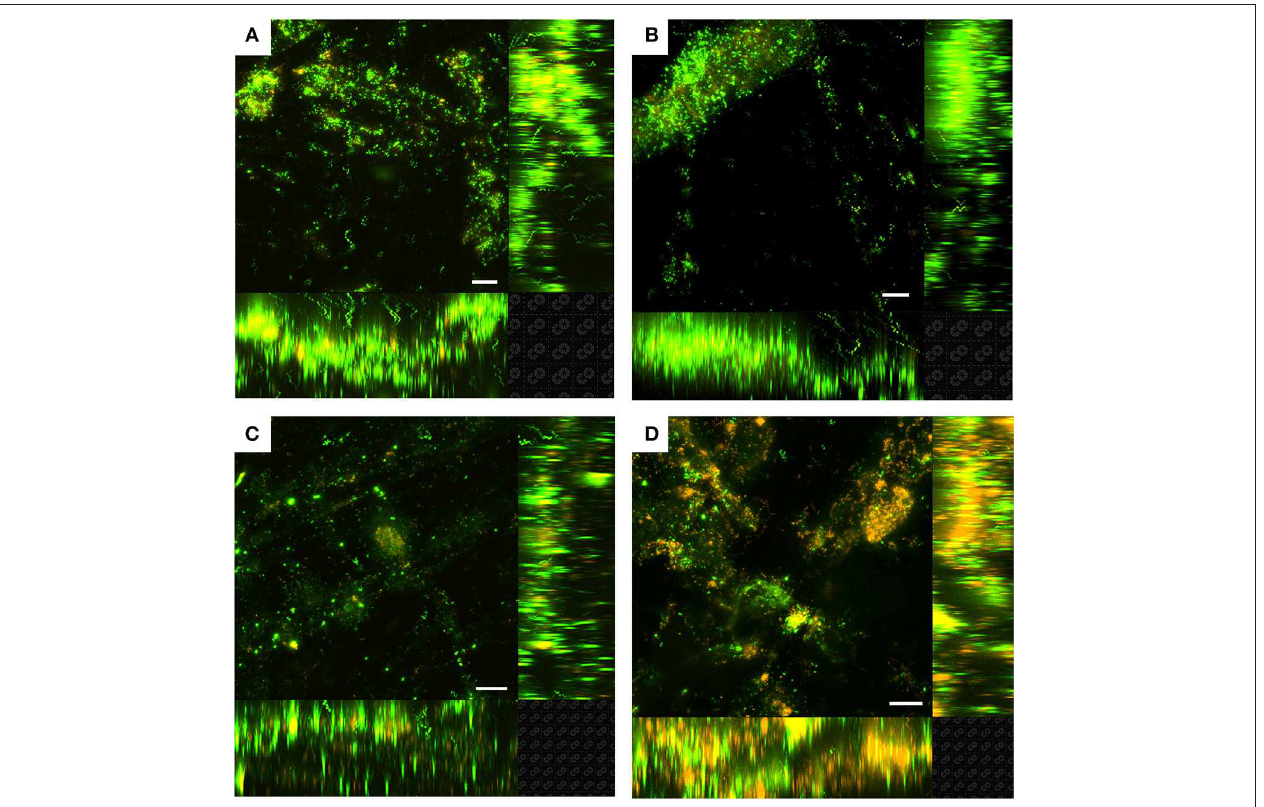
FIGURE 3 | Laser scanning confocal microscopy (LSCM) of Live/Dead-stained M. atlanticus biofilms grown on carbon cloth electrodes poised at (A) 510mV, (B) 310mV, (C) 260mV, and (D) 160mV vs. SHE after ca. 25h. Fluorescence associated with SYTO9 is shown in green (live) and fluorescence associated with propidium iodide is shown in red (dead). Representative images are shown from triplicate reactors. The white scale bar represents 20 µ